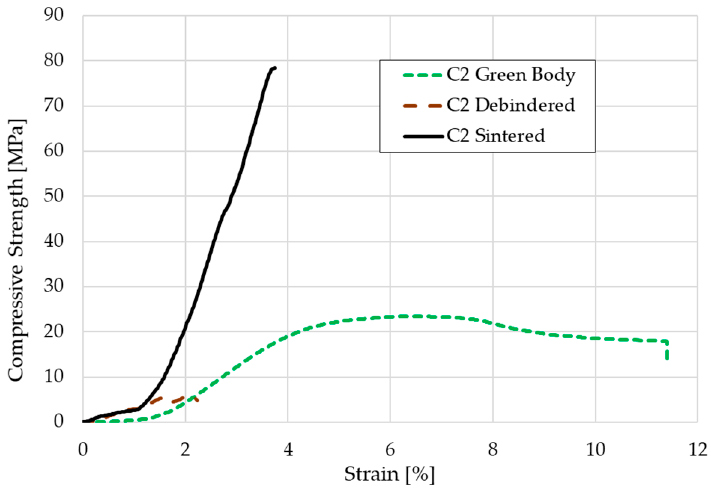
Figure 10. Stress-strain-curve for a C2 based green body, brown body, and sintered scaffold.